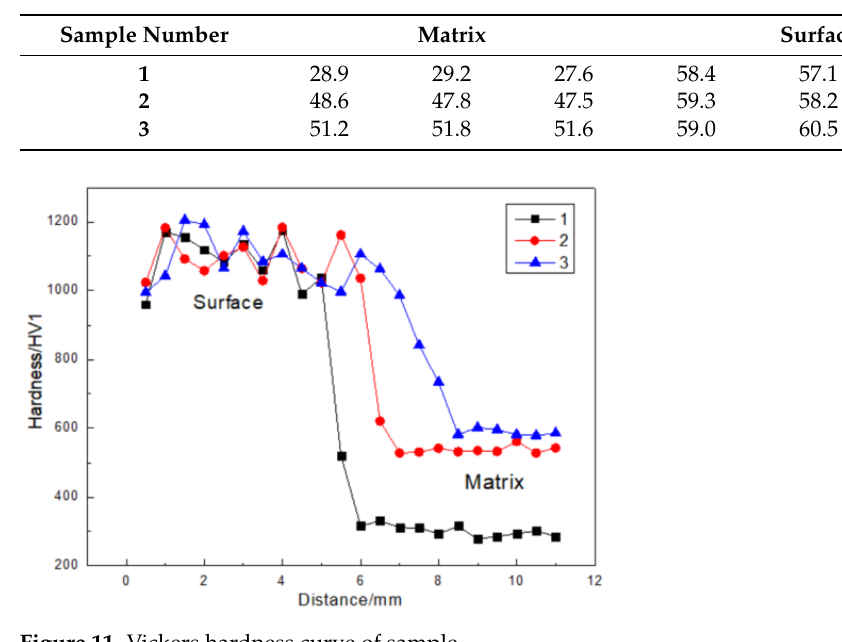
Table 5. Rockwell hardness test results of samples.